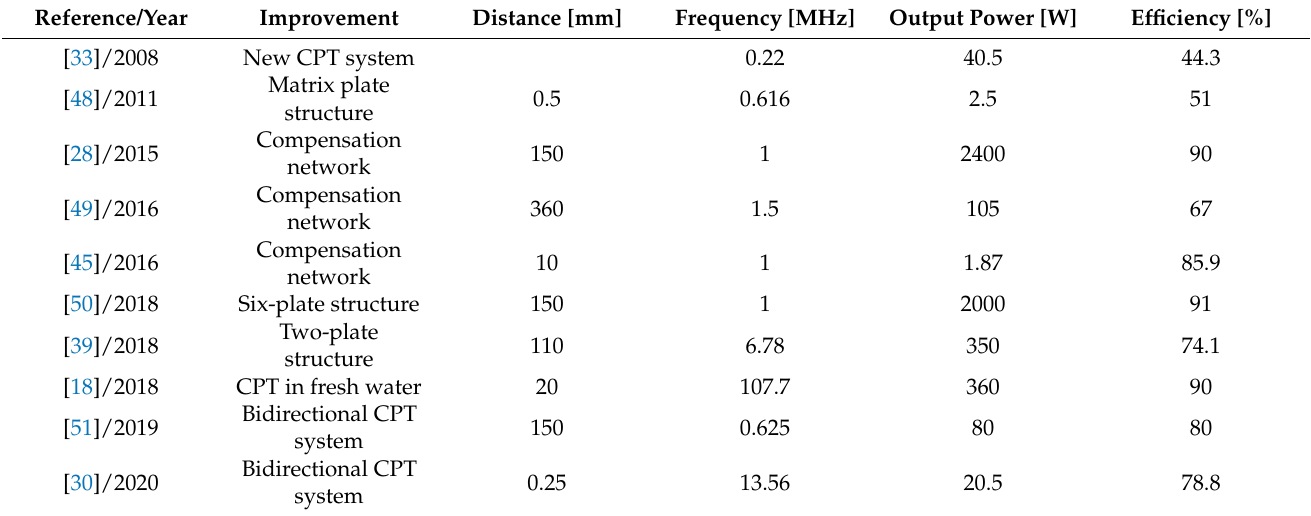
Table 2. Improvements on CPT over the last